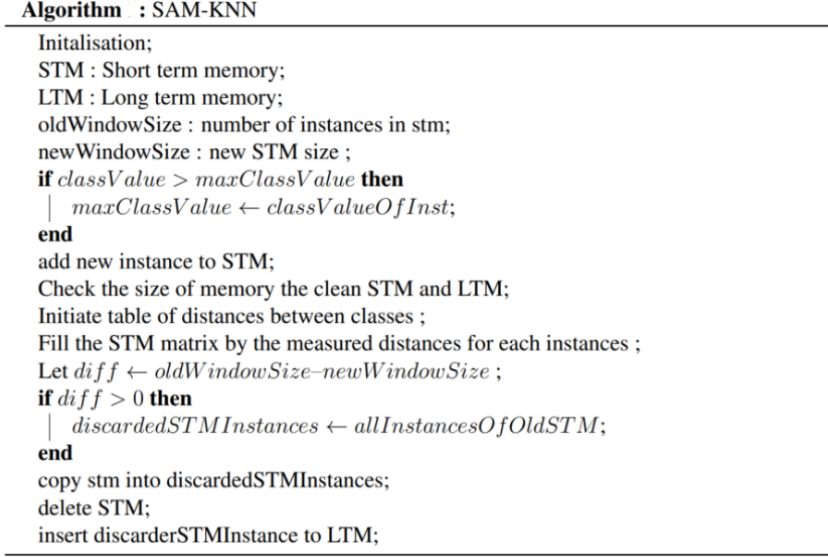
Figure 6. The pseudo code of SAMKNN [46] .